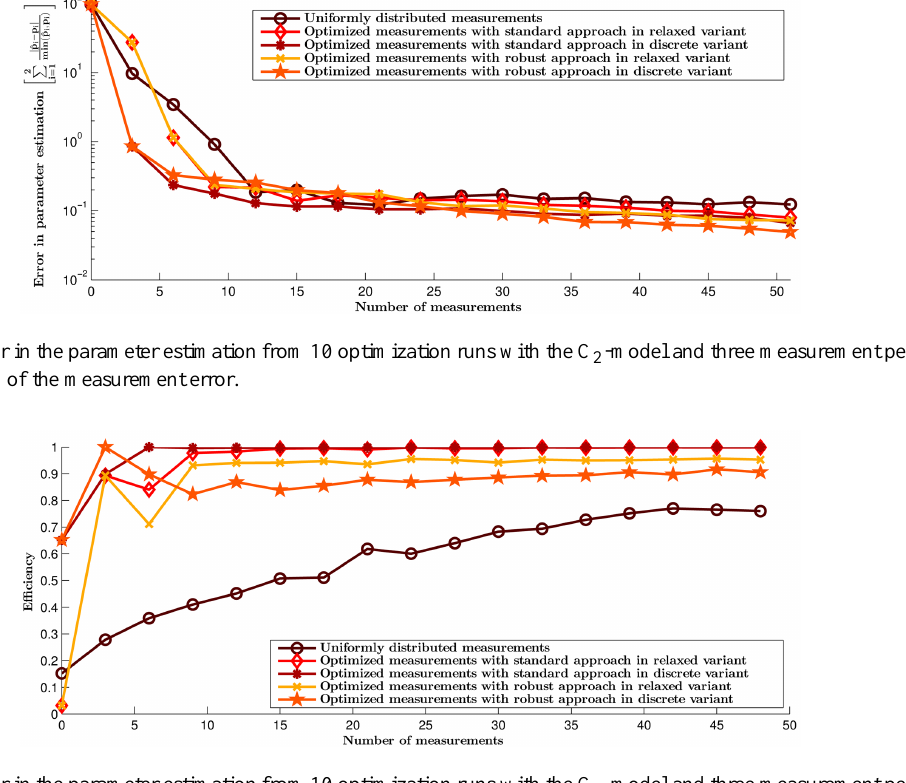
Figure 2. Averaged error in the parameter estimation from 10 optimization runs with the C 3 -model and three measurement per iteration with standard deviation 10 − 2 of the measurement